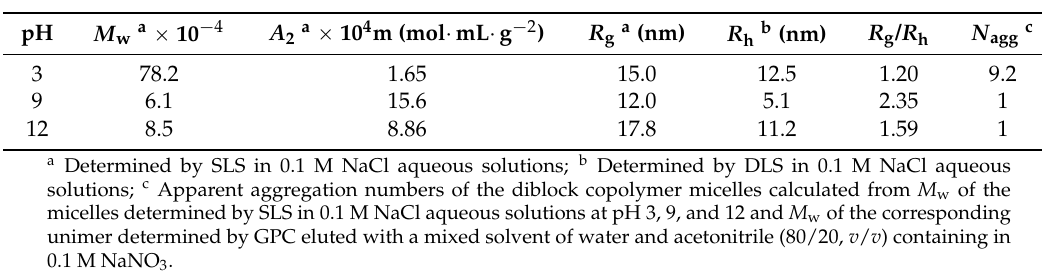
Figure 4. Zimm plots for PAMPS–PAaU at pH 3 ( a ), 9 ( b ), and 12 ( c ) in 0.1 M NaCl aqueous solutions. The Rayleigh ratio ( R θ ) was determined by subtracting the solvent scattering from the total scattering of the solution. The red and blue lines indicate the concentration ( C p ) dependence at scattering angle ( θ ) = 0 and θ dependence at scattering angle ( θ ) = 0, respectively. Table 2. Static and dynamic light scattering data for the polymer micelles formed from PAMPS–PAaU at pH 3, 9, and 12.